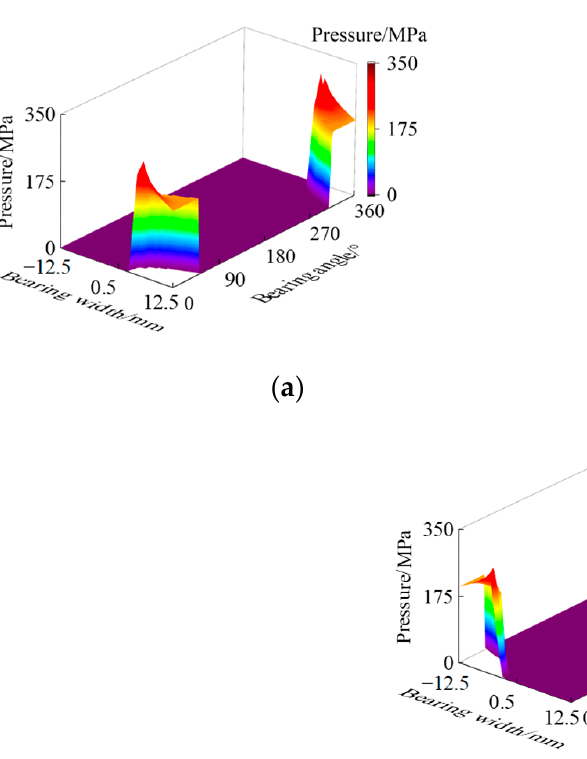
Figure 8. Friction power of bushing and piston pin boss.